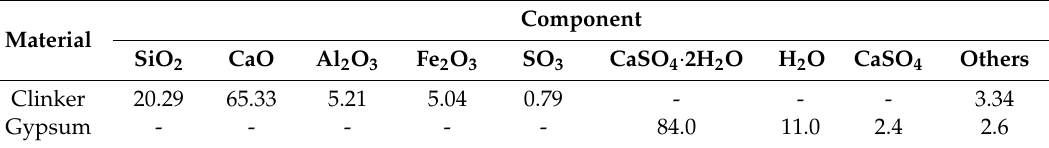
Table 1. Partial chemical compositions of the ground